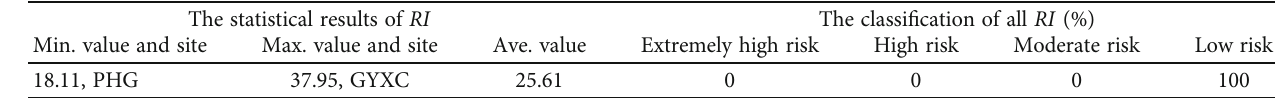
Table 3: The statistical results of RI .